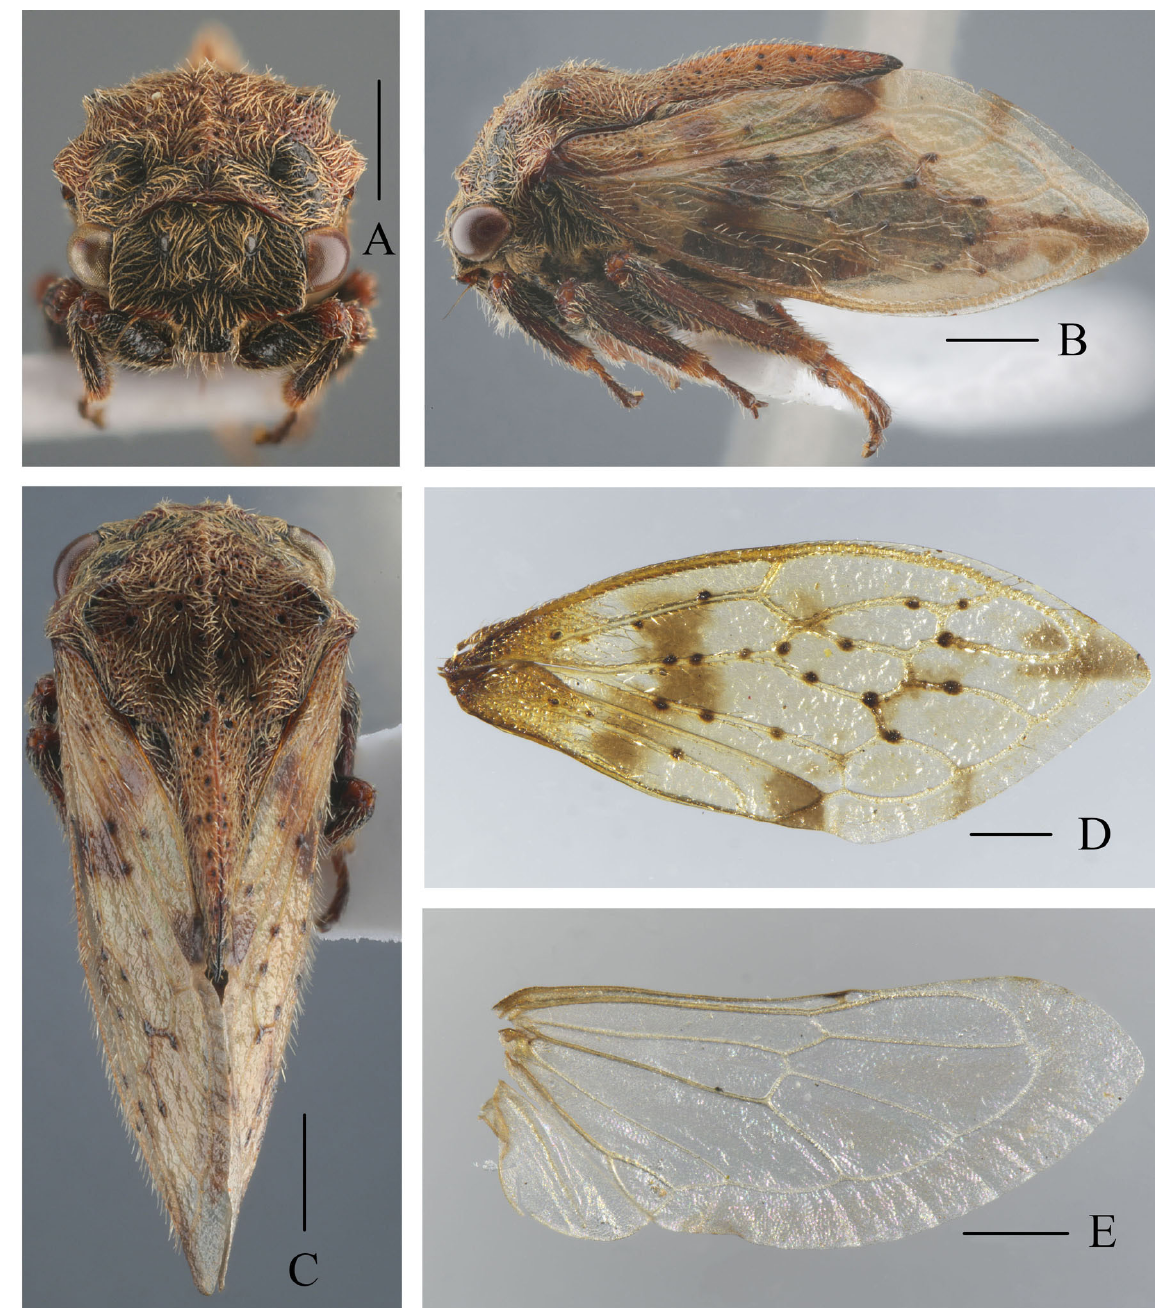
Fig. 5. Machaerotypus nodulus Li & Chen sp. nov., holotype, ♂ (IEGU). A–C . Habitus in frontal, lateral and dorsal view. D . Forewing. E . Hind wing. Scale bars: A–C = 1 mm; D–E = 0.5